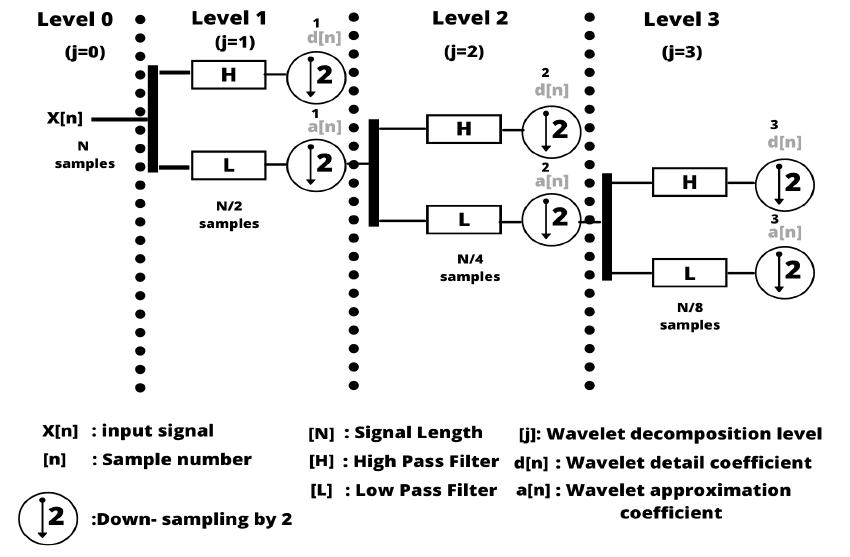
Figure 6. Schematic representation of the analysis stage of the discrete wavelet